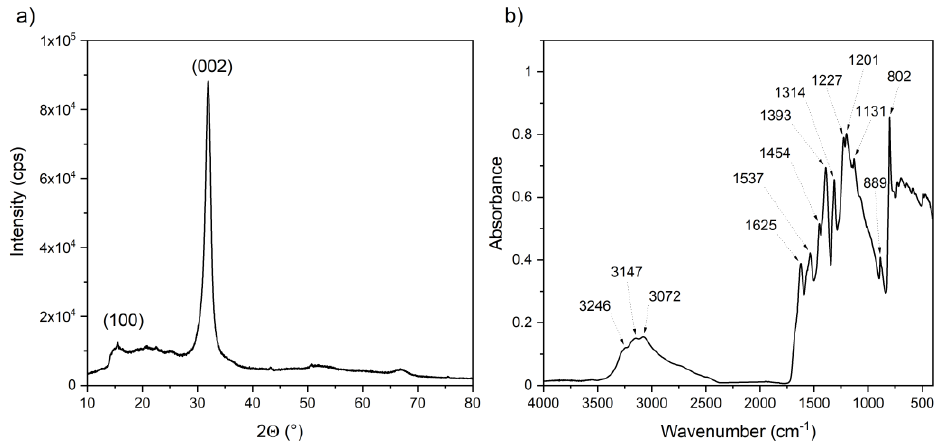
Figure 3. ( a ) Diffraction pattern of gCN sample and ( b ) FTIR spectra of the gCN sample.